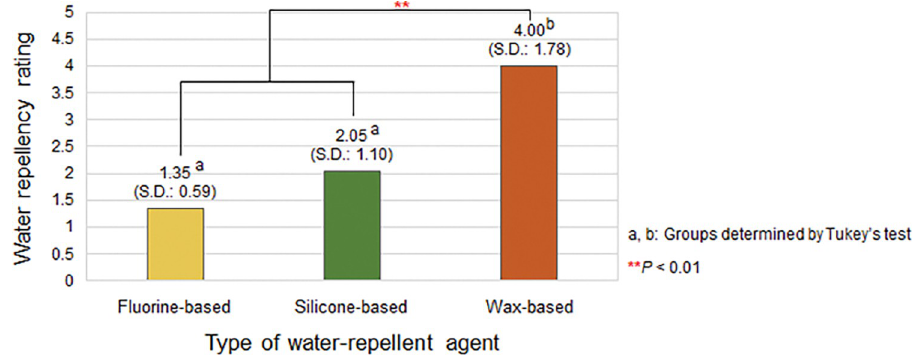
Fig 4. Water repellency of the cotton woven fabric according to the type of water-repellent agent. The result is the average rating of the fabrics of all numbers of coating layers under each water-repellent agent condition.